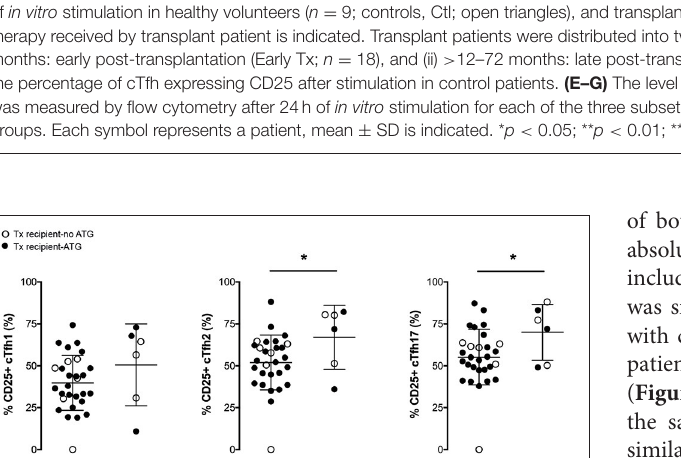
FIGURE 4 | Tacrolimus blocks more efficiently the activation of cTfh. The percentage of CD25-expressing cTfh of each of the three subsets (cTfh1; Tfh2; and cTfh17) was enumerated by flow cytometry after 24h of in vitro stimulation in transplant patients ( n = 36, circles). The nature of induction immunosuppressive therapy received by transplant patient is indicated. Transplant patients were distributed into two groups according to the CNI used for maintenance immunosuppression: (i) tacrolimus (Tacro; n = 30), and (ii) ciclosporin (Ciclo; n = 6). Each symbol represents a patient, mean ± SD is indicated. * p < 0.05; Unpaired t